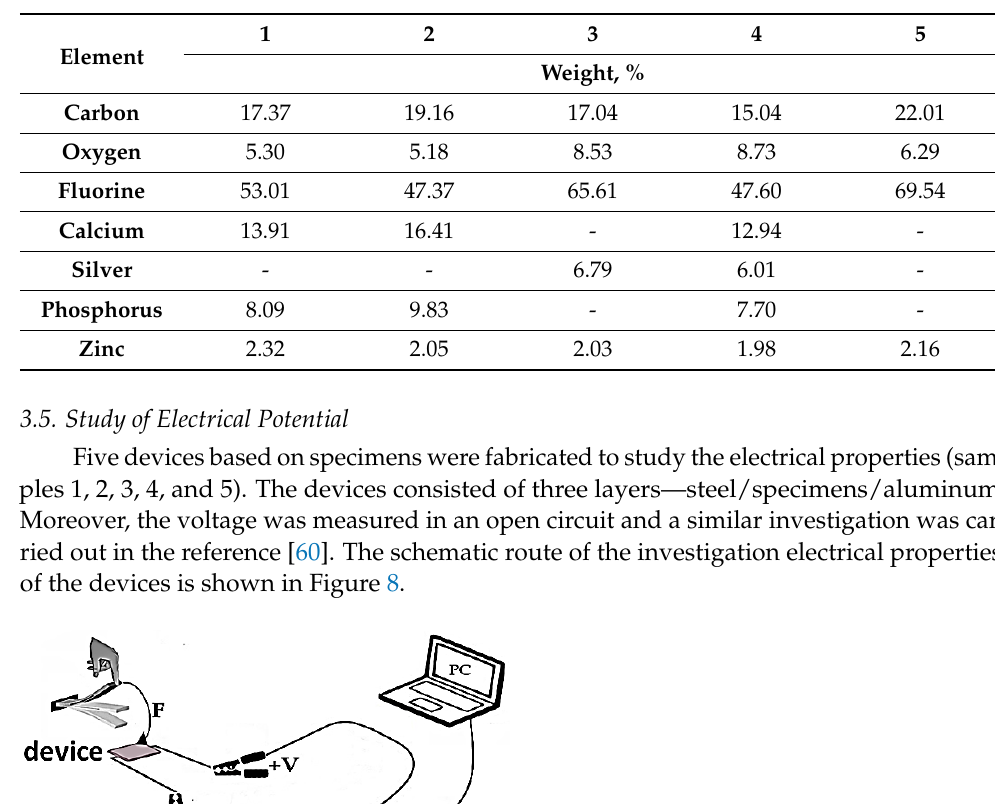
Table 3. The extracted energy values from electrical properties of devices.